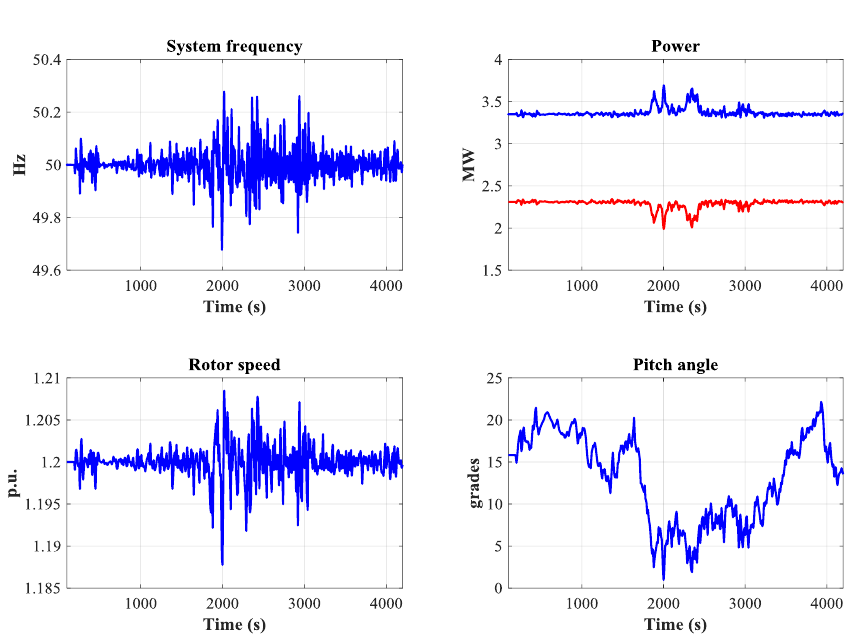
Figure A1. Dynamic responses of the system in case A during wind speed fluctuation.